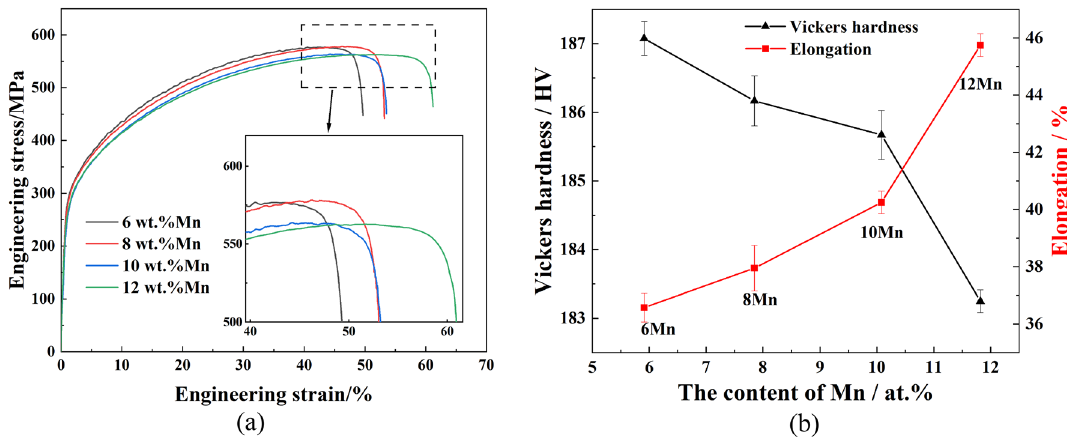
Figure 10. Test results of the mechanical properties of high-Mn AFA steel with different Mn content: ( a ) stress– strain curve ( b ) Vickers hardness and